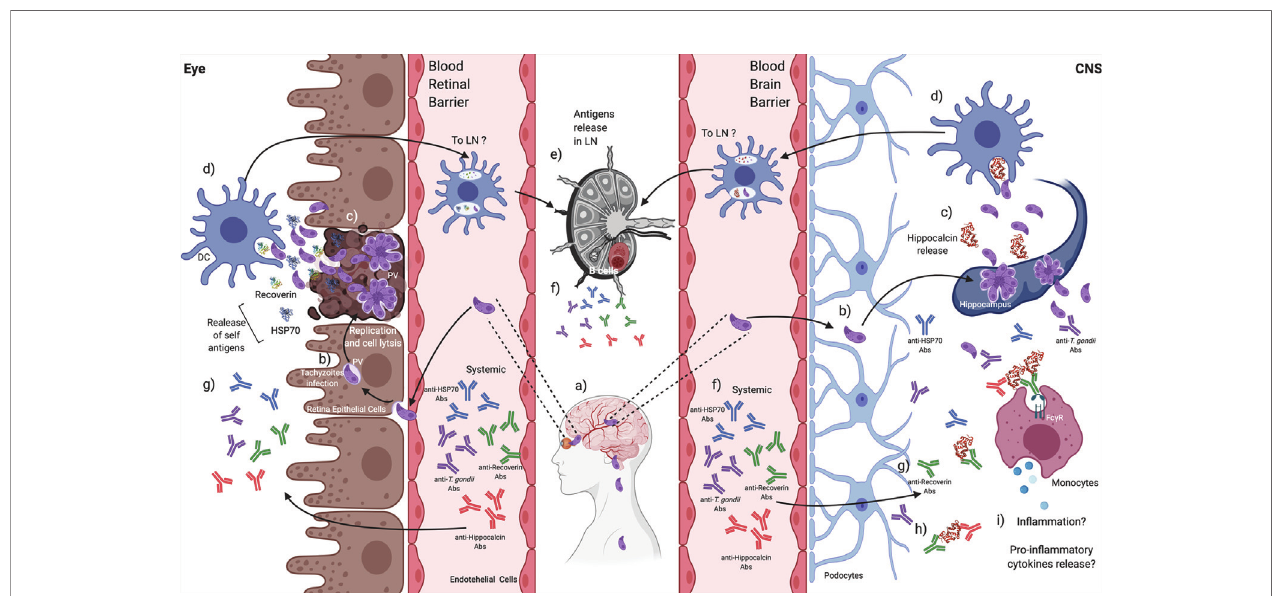
FIGURE 10 | T. gondii induces the production of autoantibodies that might be related to disease severity in CNS or the eye. a) T. gondii tachyzoites can migrate throughout the blood to reach the CNS and the retina, b) infecting local cells. c) Tachyzoites replication and exit promote lysis, and endogen antigens are released from damaged tissues. d) Tissue-resident DCs could recognize and engulf T. gondii tachyzoites and endogen antigens. e) DCs activation can promote its mobilization to the closest lymphatic node (LN) to present antigens, f) probably activating B cells to produce anti- T. gondii and anti-endogen antigens antibodies that can be detected systemically. g) These antibodies could reach the retina and the CNS. h) Autoantibodies against recoverin show cross-reactivity against other self-antigens such as hippocalcin, i) which in CNS might be related to increasing a pro-in fl ammatory environment bene fi cial against the parasite. Created with